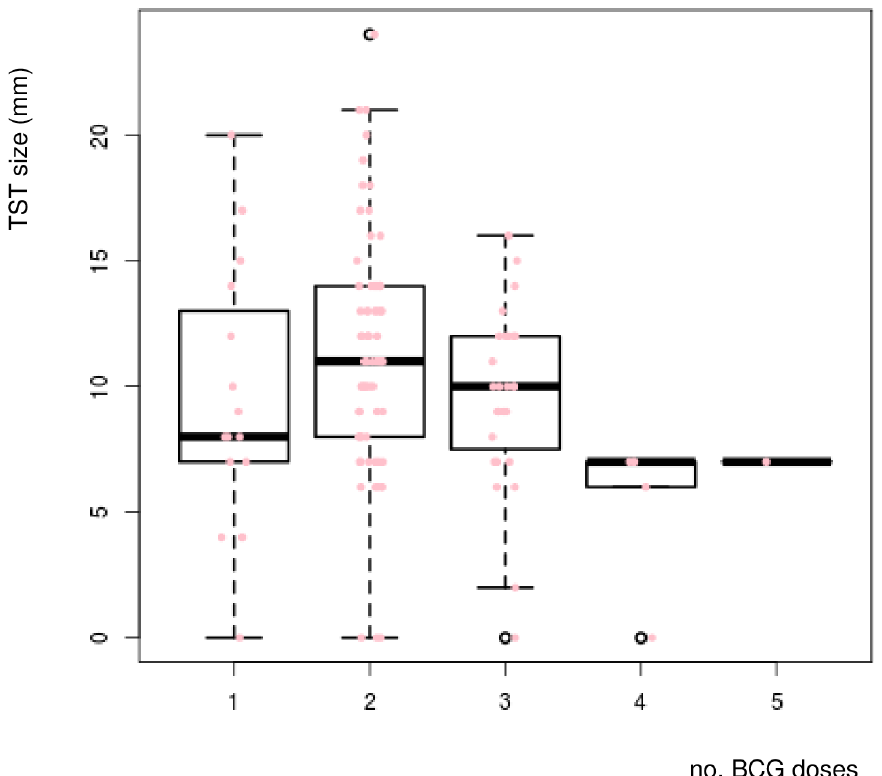
Fig 1. Correlation between TST size and the number of BCG doses in the group of healthy, young individuals. reactions to PPD with a diameter of skin induration greater than 10 mm were developed sig- nificantly more frequently by TB patients (60%) than among non-TB patients (28%) (p = 0.0006; one-sided proportion test) (Table 2). The frequency of IGRA positives was 60% among TB patients and 13% among non-TB patients (p = 0.00001). One out of 80 (1%) TB patients had an indeterminate result of an IGRA test (Table 2). Among 48 TST(+) patients with TB 37 had positive IGRA results (IGRA(+)), and among 13 TST(+) patients from non-TB group 4 were IGRA(+). Table 3. Distribution of TST sizes according to the BCG inoculations. BCG doses (n)